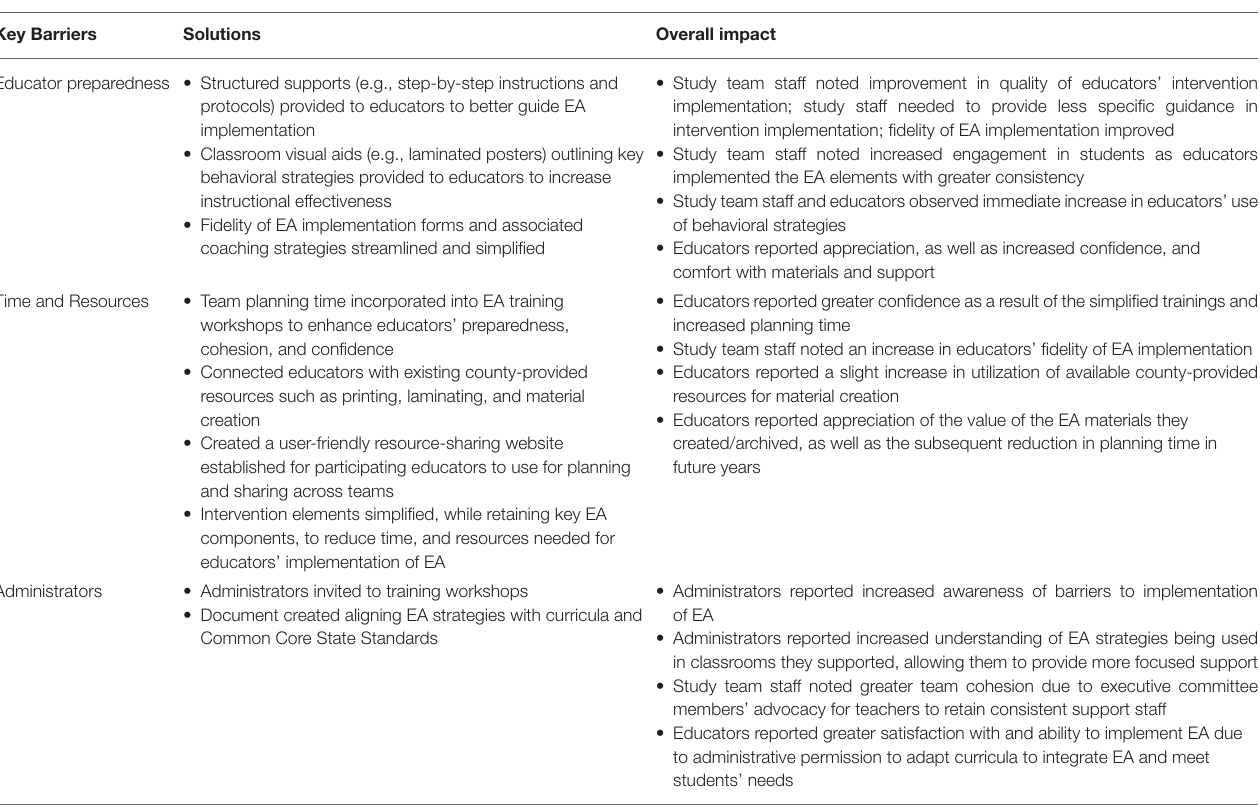
TABLE 4 | Key barriers, solutions, and overall impact. Key